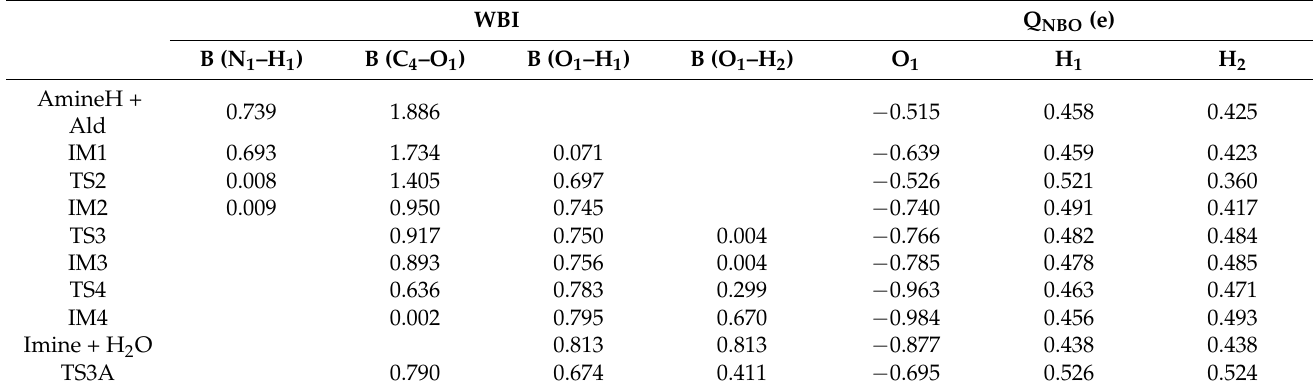
Table 3. WBI and Q NBO values for the amine–aldehyde condensation reaction. WBI